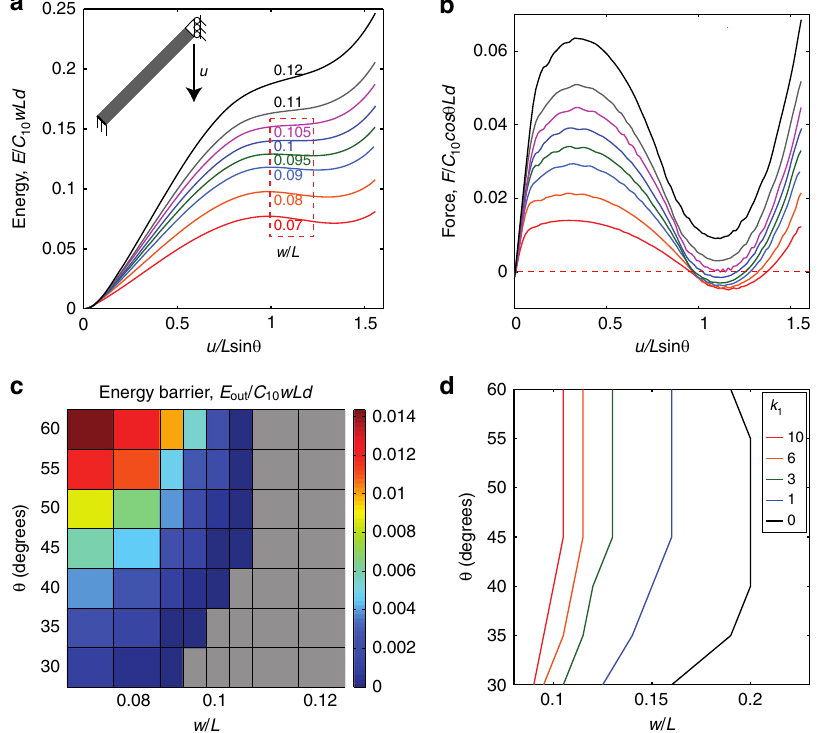
Fig. 3 Finite element analysis to determine the phase boundary for anisotropic materials. a , b Energy and force, respectively, as a function of displacement, for a beam with θ = 45 o and a w/L ratio varying from 0.07 to 0.12. The dashed box indicates bistable w/L values. c Energy barrier, E out , necessary for a buckled beam to snap back to its undeformed con fi guration (the gray region indicates that the beam is monostable). d The phase boundaries as a function of anisotropy, where k 1 = 0 indicates an isotropic material and increasing k 1 indicates increasing anisotropy (i.e., larger stiffness ratio E L / E T ); everything to the left of a particular line is bistable for that value of k